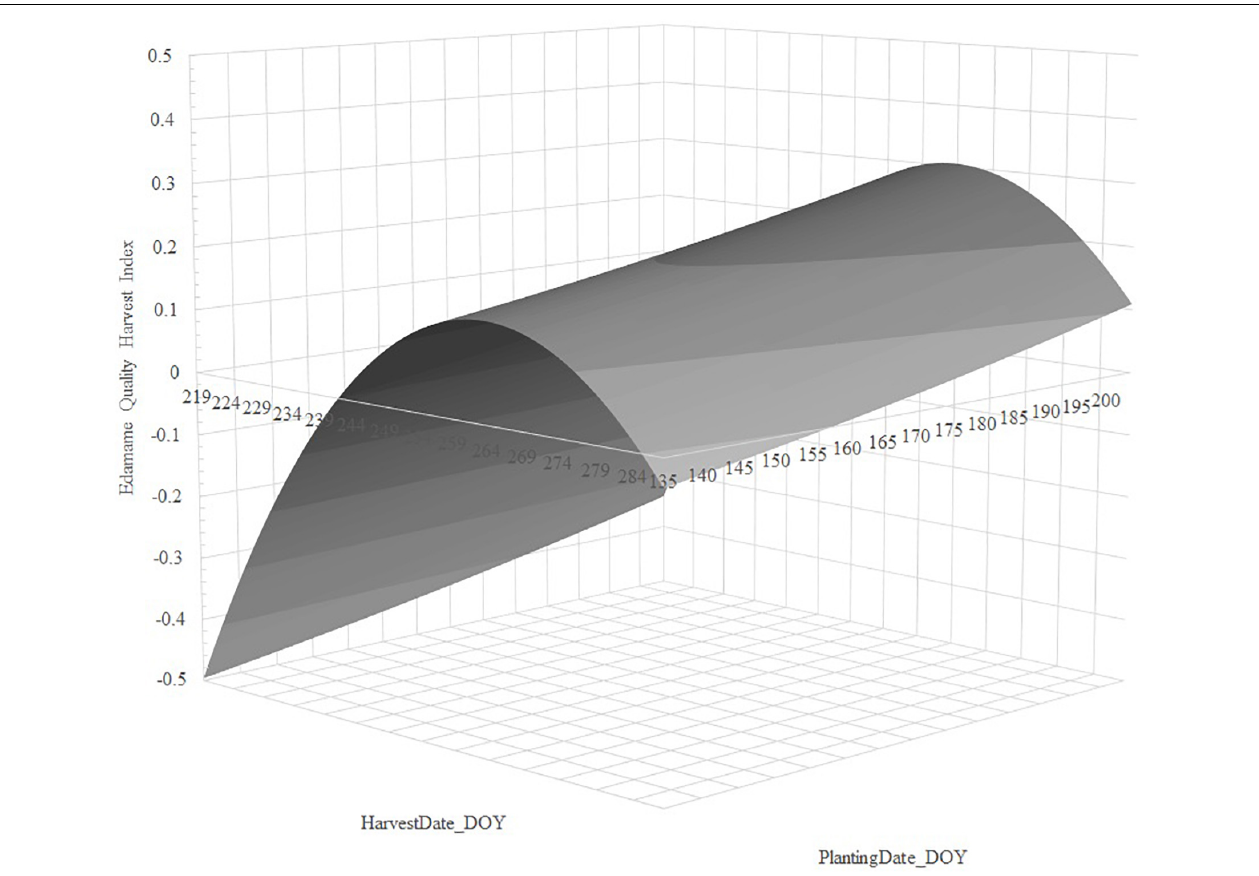
FIGURE 3 | Predicted response of Edamame Harvest Quality Index ( EHQI ) for cultivar R08-4002 as a function of the regression of EHQI on PlantingDate_DOY 2 , HarvestDate_DOY , and HarvestDate_DOY 2 . Stepwise regression calculated from the dataset of edamame cultivar R08-4002 planted on two Arkansas locations over 2 years in three planting dates and subjected to up to eight harvests dates, approximately 5 days apart, between R5.8 and R7. PlantingDate_DOY was not significant in the stepwise analysis and was not used to build this response